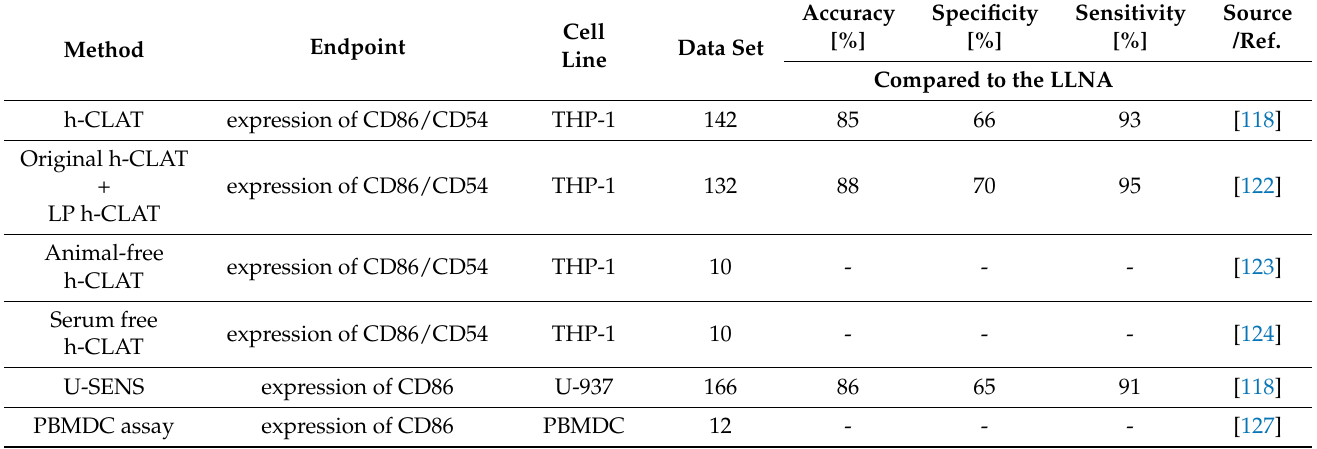
Table 6. KE3. Summary of